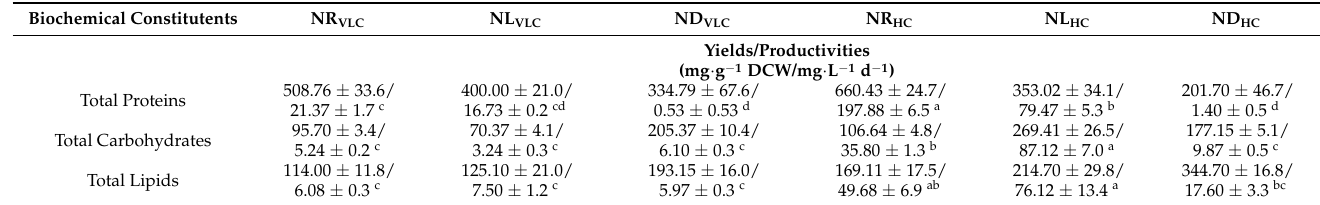
Table 2. Biochemical constituents on the 10th day of cultivation i.e., total proteins, total carbohydrates, and total lipids subjected to NR VLC , NL VLC , ND VLC , NR HC , NL HC , and ND HC conditions in the native isolate Monoraphidium sp. CABeR41. Values indicated are mean average ( n = 3) ± S.E.; different lowercase letters indicate the statistical significance by two-way ANOVA with p -value < 0.05 using post hoc analysis by Tukey’s honestly significant difference